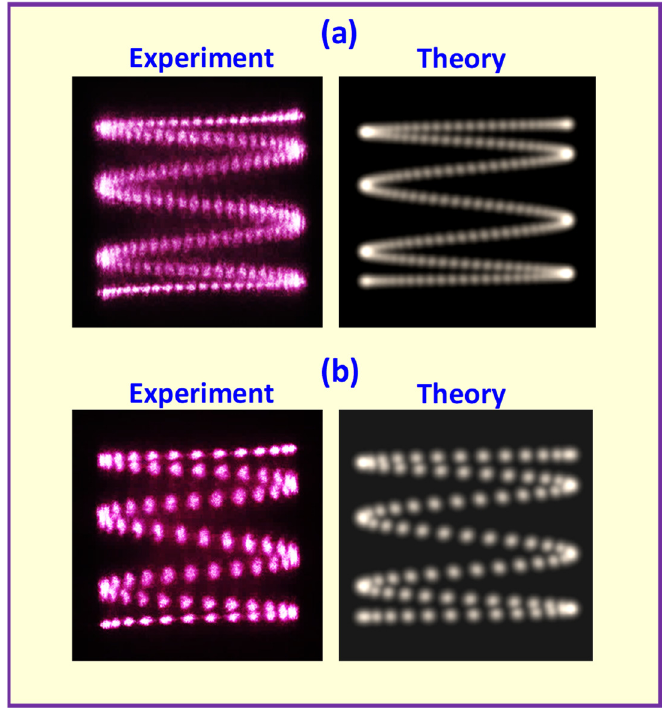
Figure 13. Experimental and theoretical far-field transverse patterns for the cases of ( a ) M = 100 and ( b ) M = 101 to manifest the influence of the factor C d with ( P , Q ) = ( 1, 4 ) , ( p , q ) = ( 1, 7 ) , (cid:0) (cid:1) = ( N x , N y 500, 300 ) , φ x = φ y = 0, m =